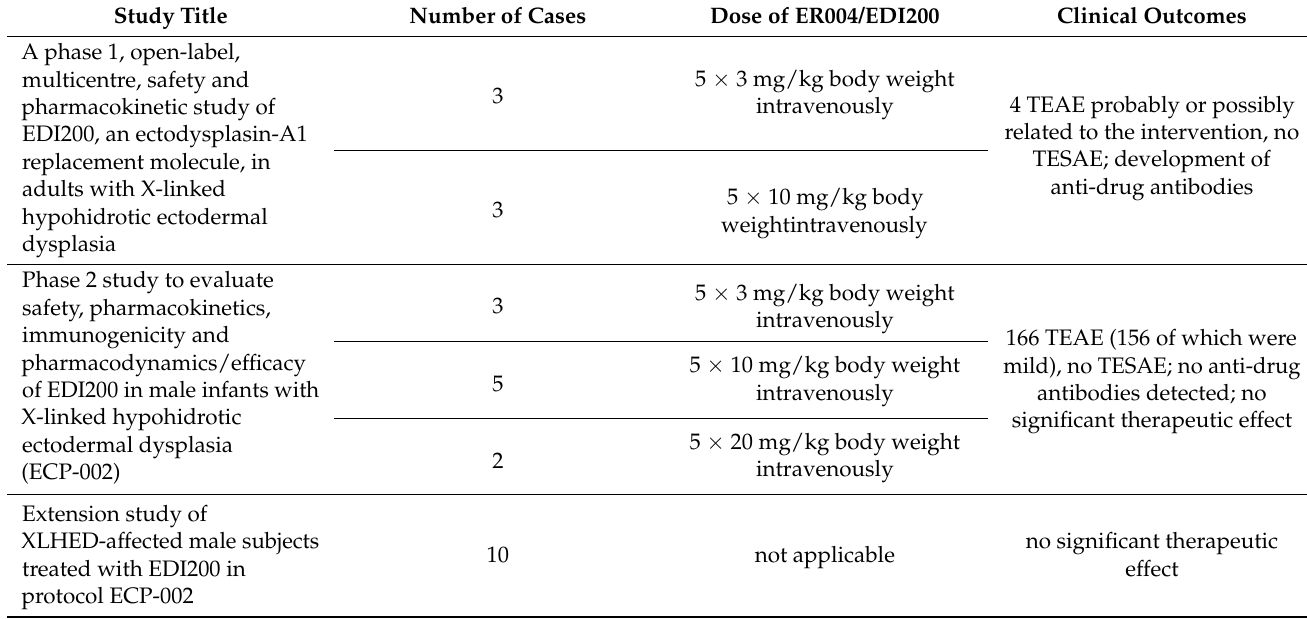
Table 1. Previous clinical trials with